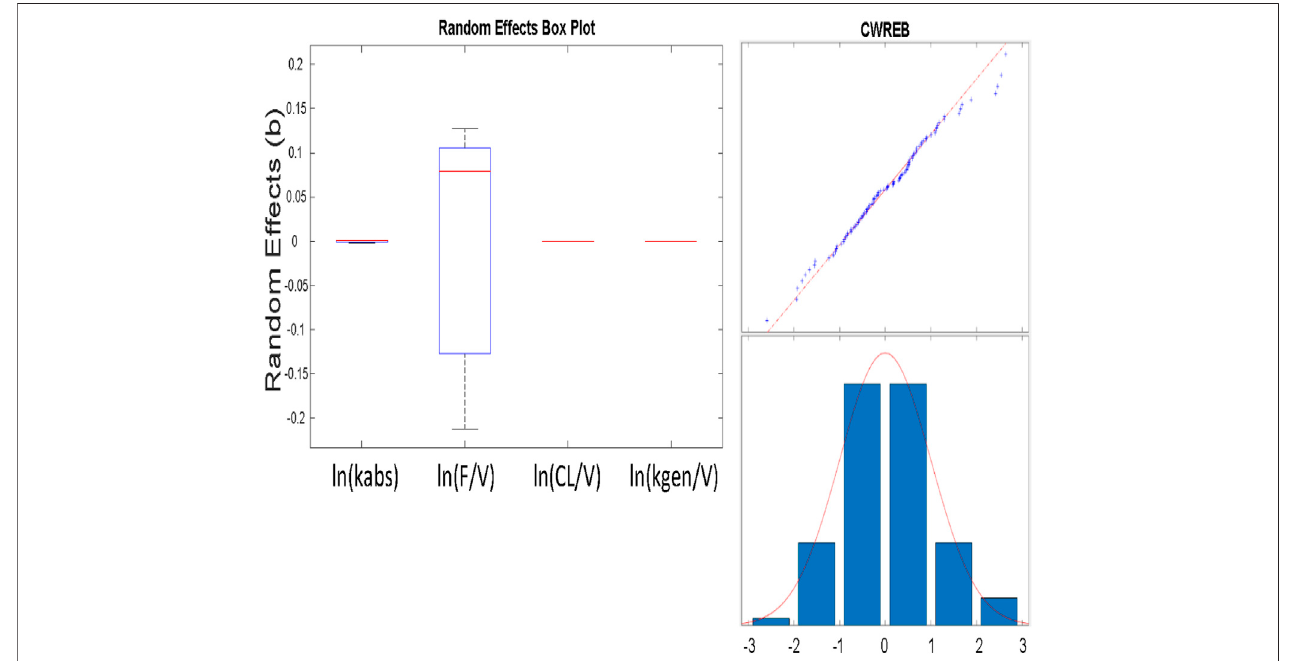
FIGURE 6 | A) (above) Box and whisker plot of estimated parameters from population fi t. Most variability is in the F/VD parameter. B) (at right) Plot of residuals to evaluate normality using a combined (constant plus proportional) error model. The combined model gave improved normality in the “ tails ” at both low and high values shown here, as opposed to a constant error